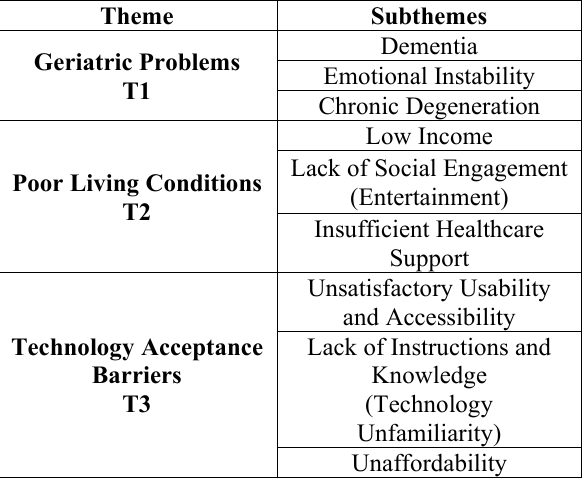
Table 1. Summary of themes